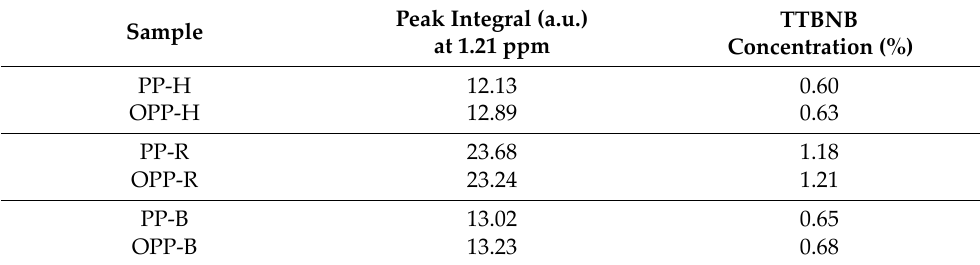
Table 4. Correlated TTBNB concentration determined by 1 H‑NMR characteristic peak